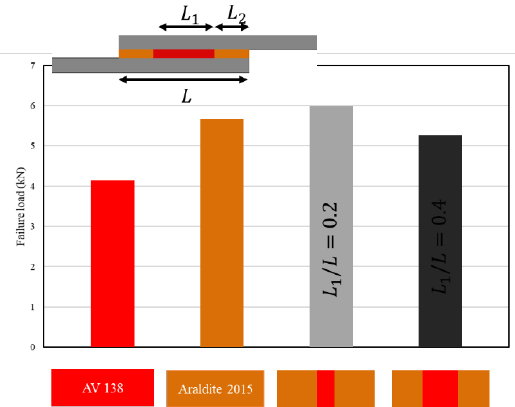
Figure 10. Effect of length ratio on failure load in mixed adhesive joint. Adapted from [109].